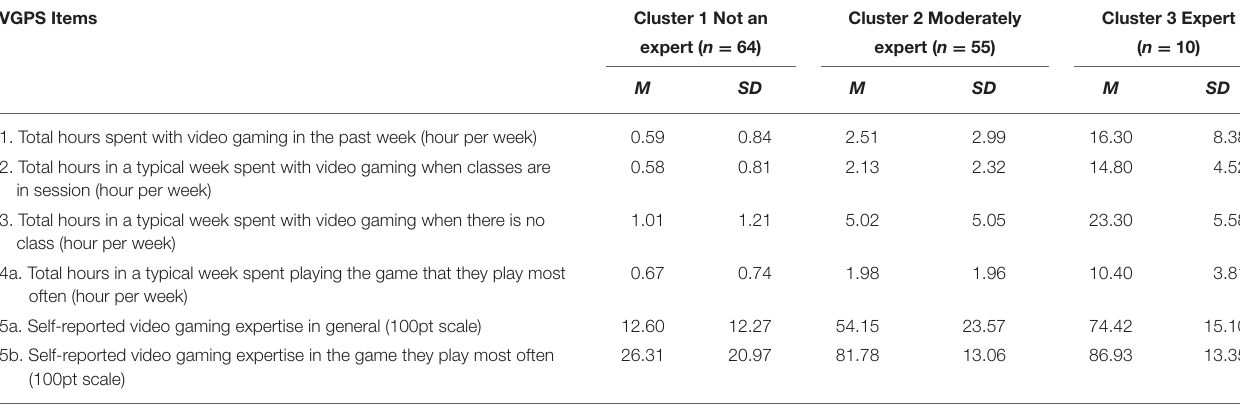
TABLE 3 | Means and standard deviations for the clustering variables for the three cluster